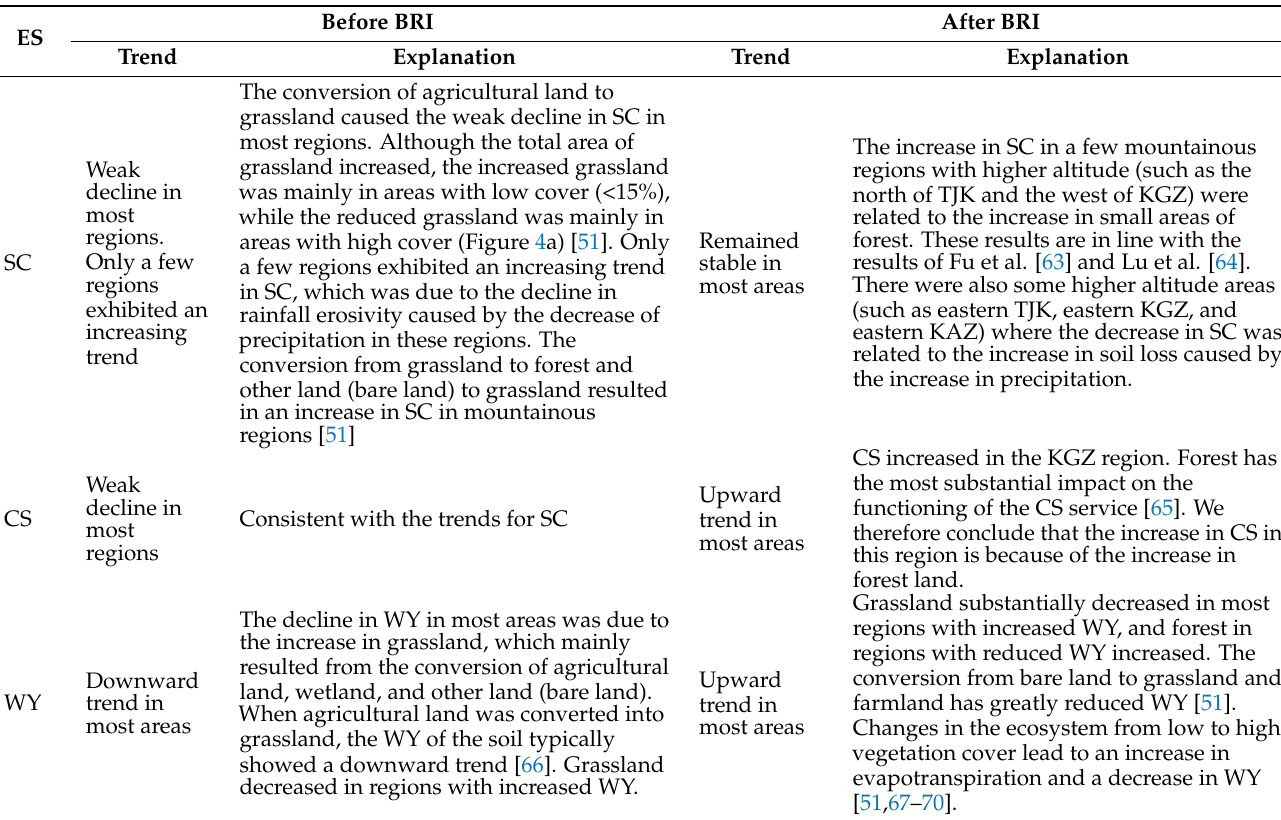
Table 9. Comparison of effect of LUCC on changes in ESs of the CANs before and after the